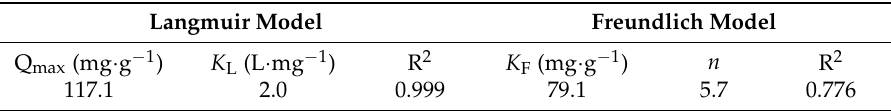
Figure 6. ( a ) Relationship between the Q e and the initial U(VI) concentration, ( b ) U(VI) adsorption isotherm for UHMWPE-g-PO 4 fibers, ( c ) linearized Langmuir, and ( d ) Freundlich adsorption isotherms by fitting the experimental data (sorbent: 0.2 g, volume: 1 L, time: 144 h, temperature: 25 °C, and NaF: 2 g∙L −1 ). Table 3. Parameters calculated from Langmuir and Freundlich models for the capture of U(VI) by UHMWPE-g-PO 4 fiber.